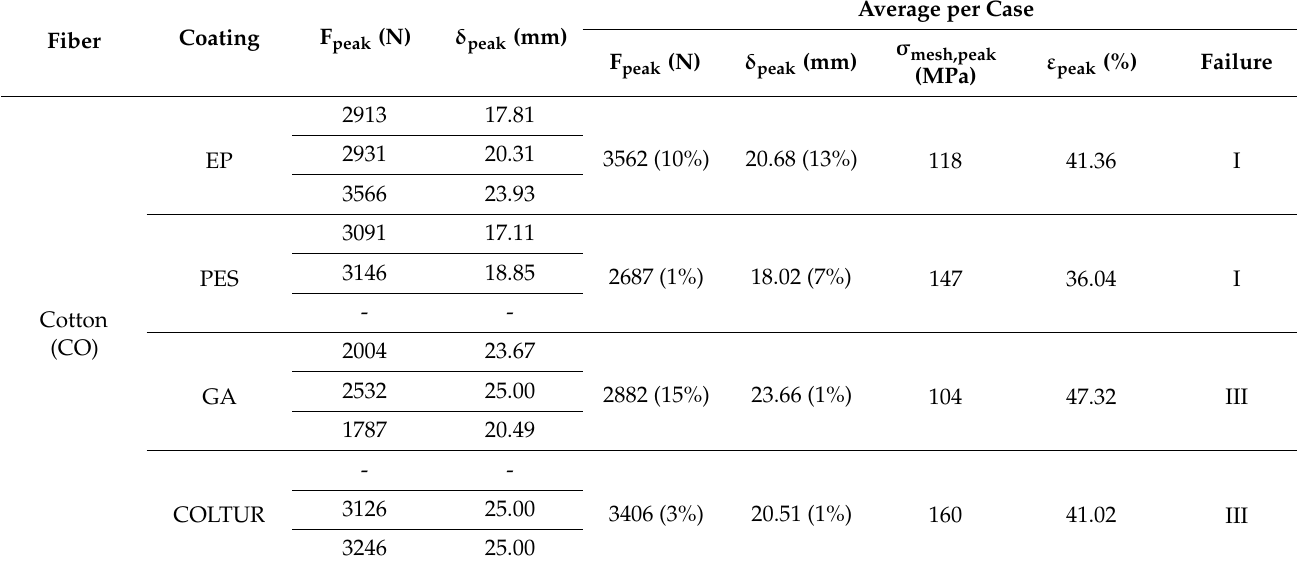
Table 9. Cotton FRCM’s tensile test results.